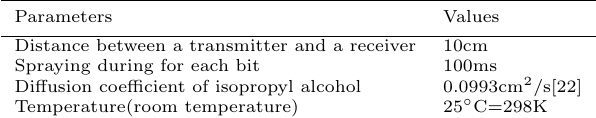
Table 1: The Experiment Parameters Parameters Values